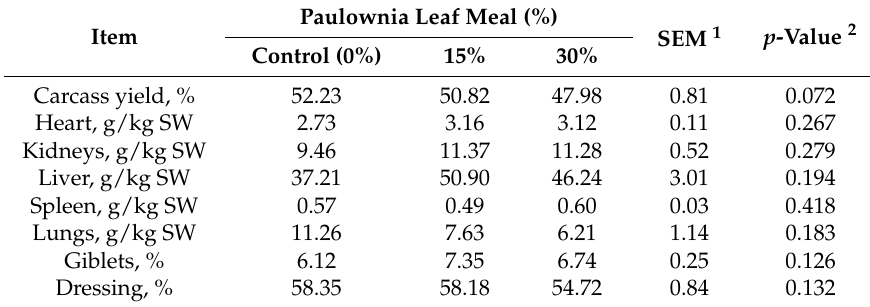
Table 4. Effects of paulownia leaf meal on carcass traits of growing New Zealand White rabbits at 13 weeks of